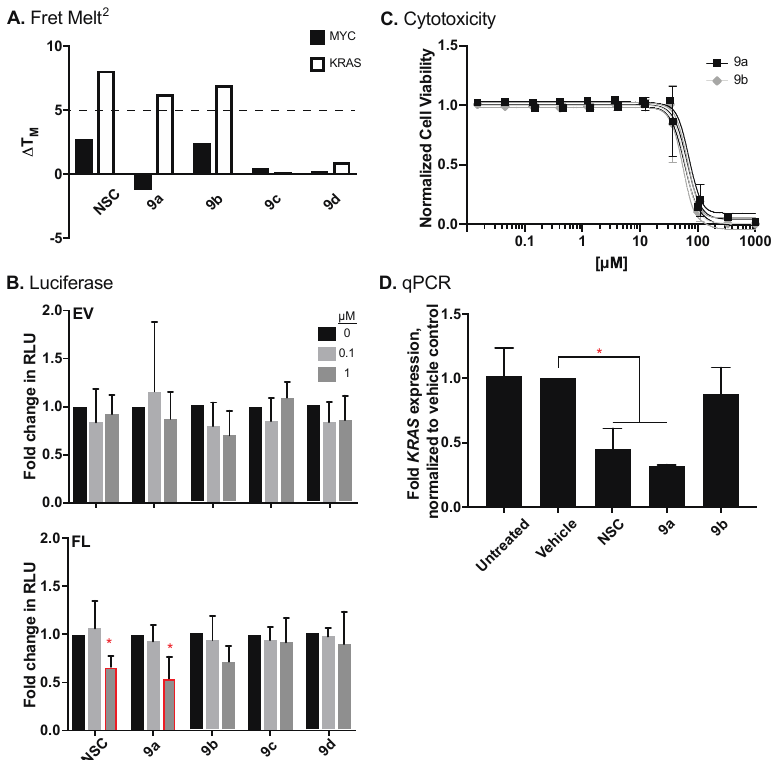
Figure 3. Effects of novel indoloquinolines on KRAS regulation. ( A ) Novel compounds were explored as G4–stabilizing compounds using the FRET Melt 2 assay, targeting either the MYC or the KRAS G4 mid structures. Thermal melts (°C) were determined by non–linear regression and changes in T M ( Δ T M ) were calculated. Based on experimental data [40,41,43], a Δ T M of 5 °C or more is a “hit”. ( B ) Compounds were further examined for changes in promoter activity using a promoterless EV for control, or a luciferase plasmid containing the KRAS promoter (FL) at concentrations of up to 1 μ M for 48 h. KRAS–dependent AsPc1 cells were utilized to compare the ( C ) cytotoxicity and correlating ( D ) changes in KRAS expression following 72 of treatment. * p < 0.05 as compared to vehicle controls, as determined by a one–way ANOVA with Tukey post-doc analysis.